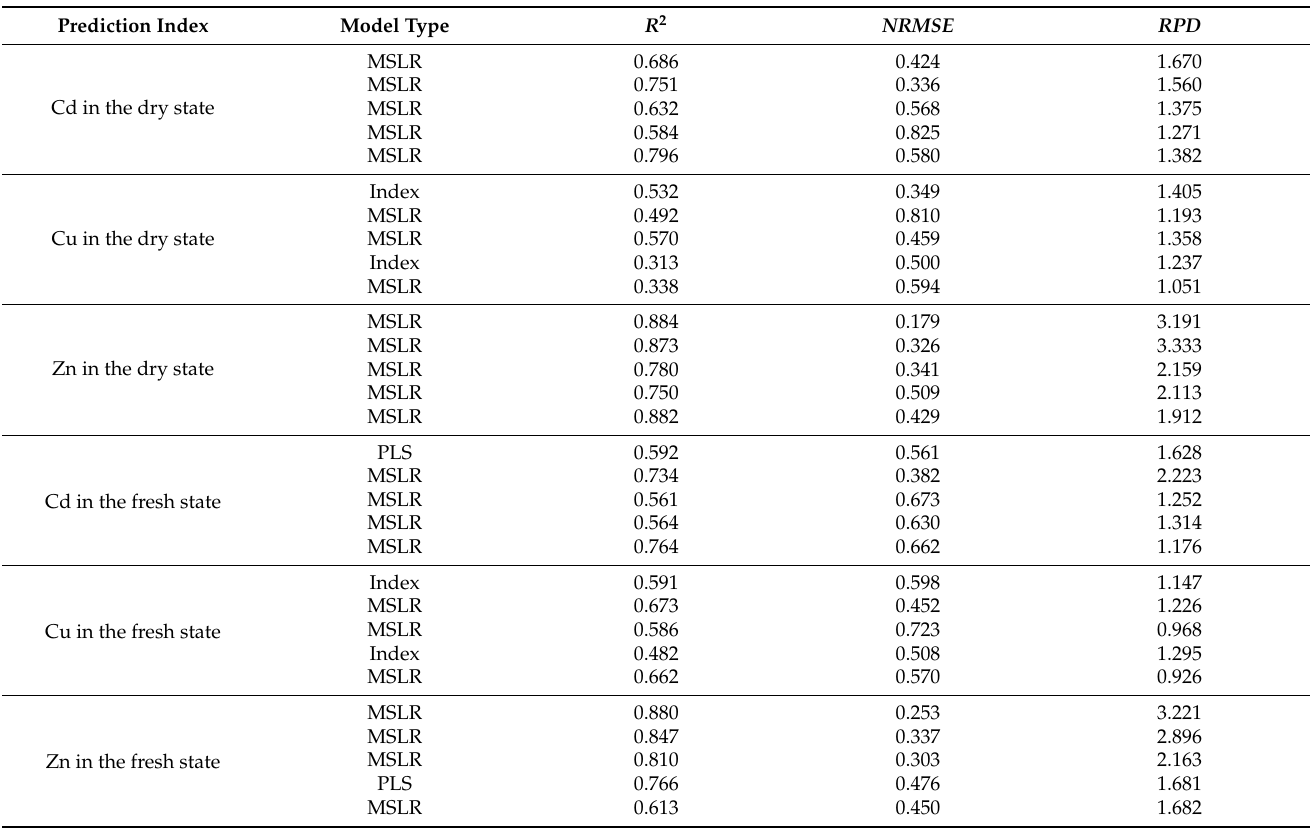
Table 4. Model types and results of model evaluation